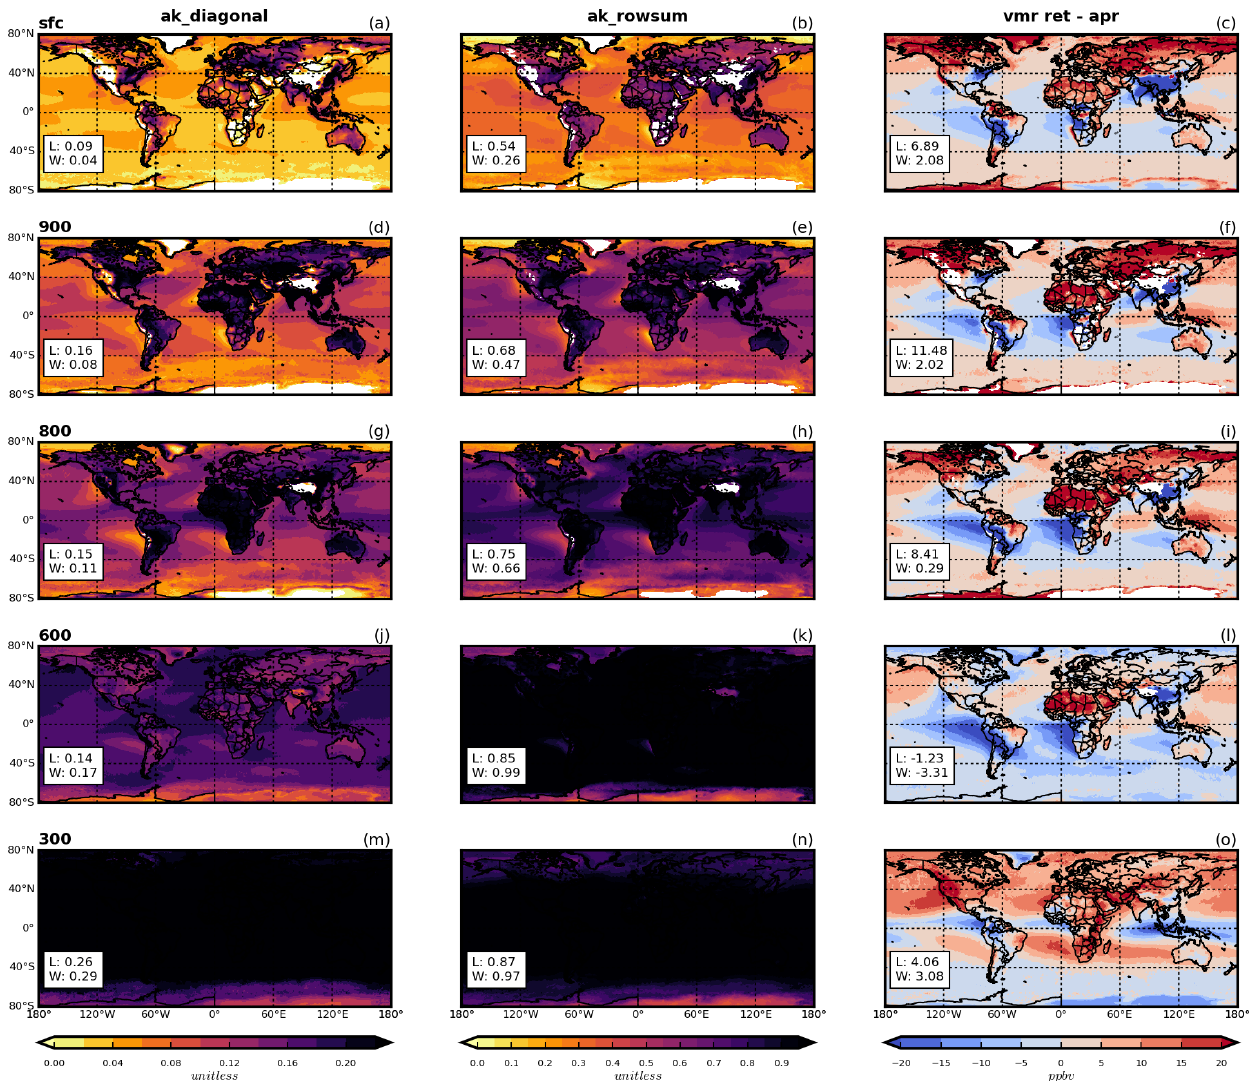
Figure 3. Mean sensitivity metrics from MOPITT L3 data, averaged across the entire study period (September 2001–February 2019, inclu- sive). Shown are AK diagonal values (left column), AK row sums (centre column), and VMR retrieved minus a priori values (right column) for the following levels of the retrieved profile: surface (top row), 900hPa (second row), 800hPa (third row), 600hPa (fourth row), and 300hPa (bottom row). Values in white boxes correspond to mean values across all land (L) and water (W) L3 grid